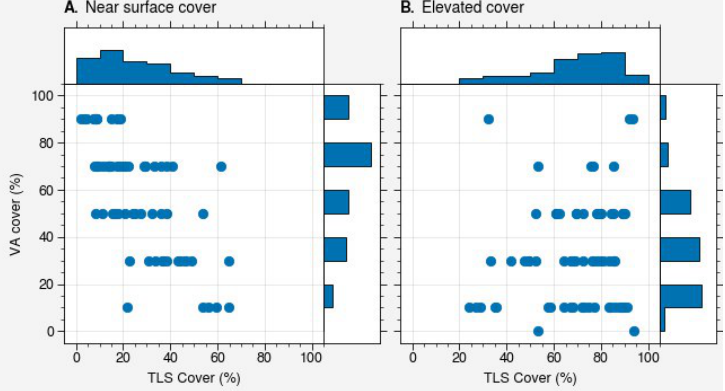
Figure 3. Joint plots comparing cover (%) for the ( A ) near-surface and ( B ) elevated fuel layers from TLS and visually assessed (VA) observations.